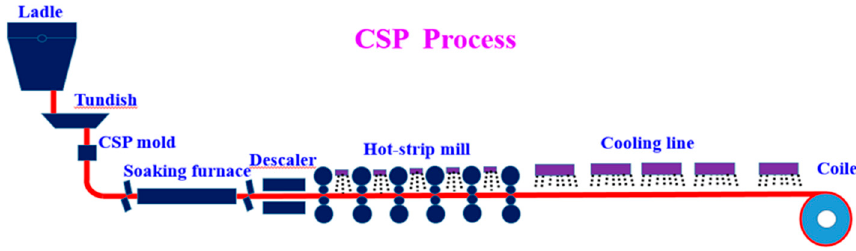
Figure 1. Schematic representation of CSP plant.